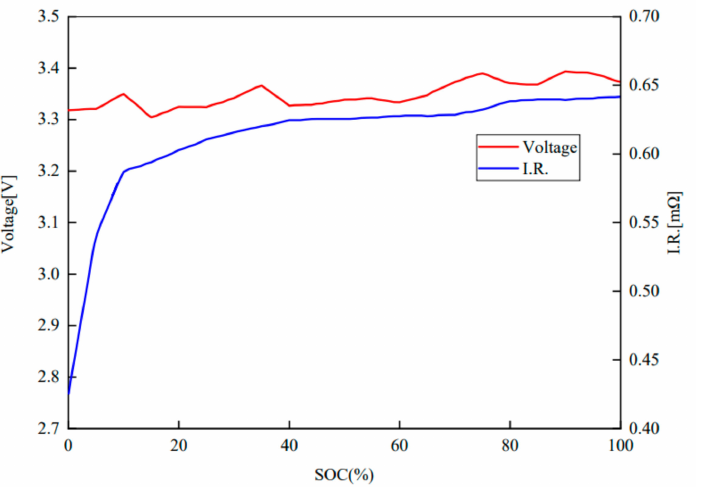
Figure 2. Relationship between open circuit voltage/internal resistance and the SOC of a single